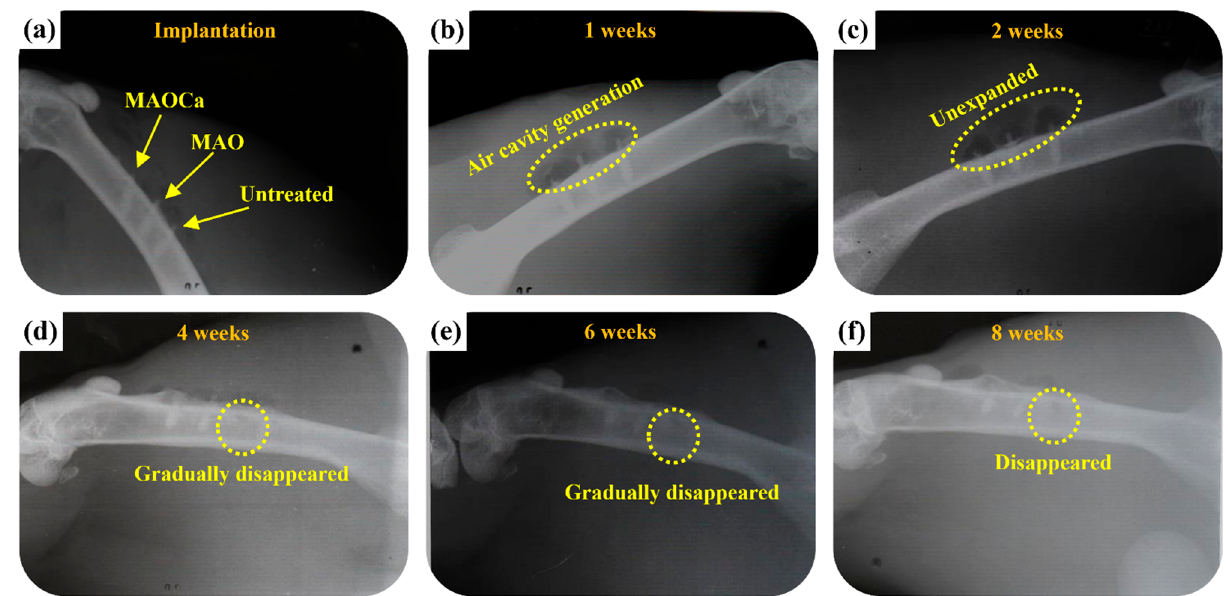
Figure 13. Plain X-rays of the various ZK60 Mg alloy bone screws in the femoral shaft of a rabbit: ( a ) Just implanted, ( b ) 1, ( c ) 2, ( d ) 4, ( e ) 6, and ( f ) 8 weeks.